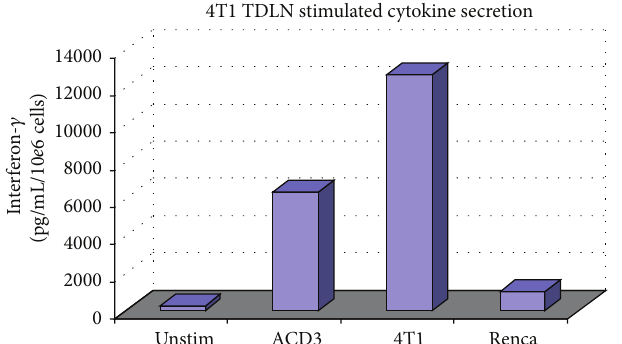
Figure 2: Activated TDLNs were cocultured alone, with immobilized anti-CD3, irradiated 4T1, or irradiated Renca tumor cells for 24 hours.